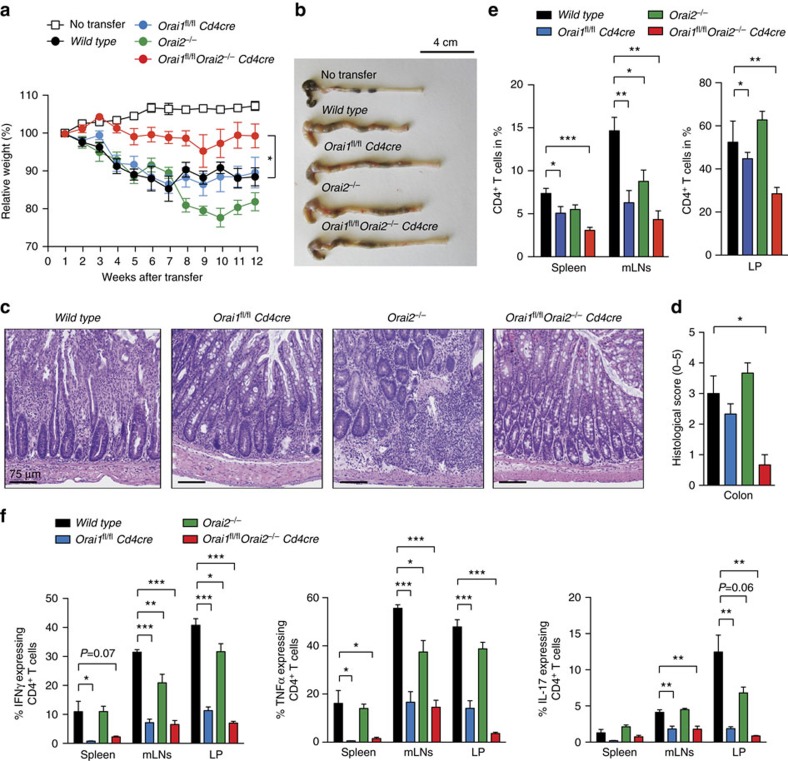
Orai1/Orai2-deficient T cells fail to induce colitis after adoptive transfer into lymphopenic host mice.(a) Weight loss of Rag1−/− host mice after transfer of 5 × 105 CD4+CD25−CD62Lhi naive T cells from WT, Orai1fl/flCd4cre, Orai2−/− and Orai1fl/flOrai2−/−Cd4cre (DKO) mice; means±s.e.m. of 9–13 mice. (b) Representative macroscopic pictures of colon samples from mice described in a. Scale bar, 4 cm. (c) Representative H&E colon histologies 12 weeks after naive T cell transfer. Scale bar 75 μm. (d) Histopathological examination of H&E-stained colon sections as shown in c; means±s.e.m. of three to four mice. (e) Frequency of CD4+ T cells in spleen, mesenteric LNs (mLNs) and LP of Rag1−/− mice 12 weeks after naive T cell transfer; means±s.e.m. of four to five mice. (f) Cytokine production by T cells isolated from spleen, mLNs and lamina propria (LP) 12 weeks after naive T cell transfer. Intracellular IFNγ, TNFα and IL-17 levels were measured after stimulation with phorbol myristate acetate (PMA)/ionomycin and analysed by flow cytometry; means±s.e.m. of four to five mice. *P<0.05; **P<0.005; ***P<0.001 using unpaired Student's t-test in (e) and two-way analysis of variance (ANOVA) in f.